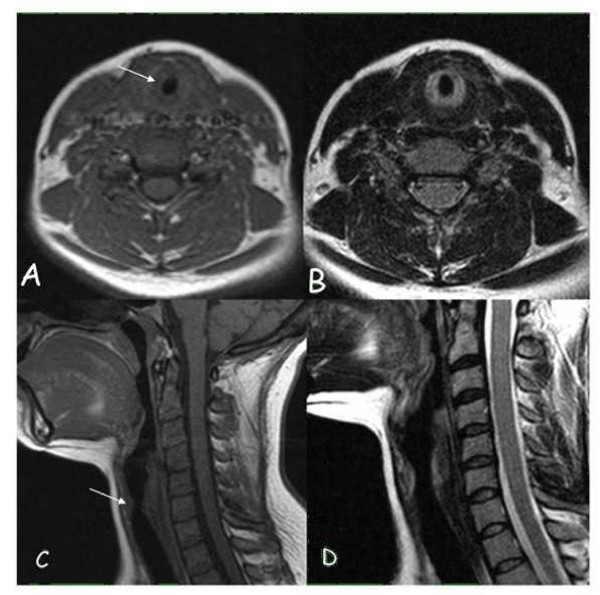
Magnetic Resonance Imaging (MRI). MRI_axial: (A) Axial T1-weighted Spin Echo (SE) MRI shows circumferential thickening of the trachea (white arrow) with intermediate signal intensity of the thickened mucosa/submucosa. (B) T2-weighted Turbo SE MRI at the same level. Note the pathological high signal intensity of the thickened mucosa/submucosa, which corresponds to mucosal inflammation. MRI_sag: (C) Sagittal T1-weighted SE MRI shows irregular narrowing of the airway (white arrow). (D) Sagittal T2-weighted Turbo SE MRI of the subglottic trachea shows thickening of the tracheal lumen with high signal intensity due to inflammation.